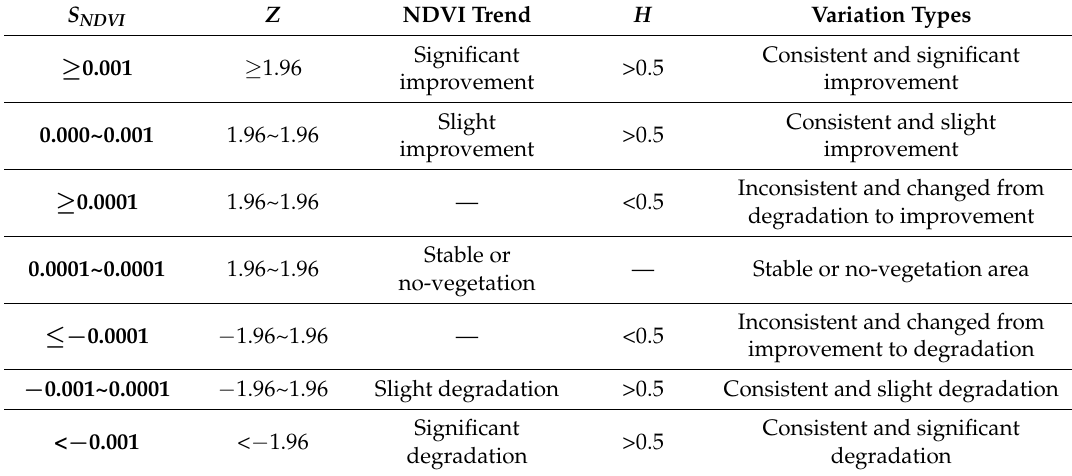
Figure 2. ( a ) Change trends of the mean NDVI in the growing season from1982 to 2015. Annual change trends in NDVI; ( b ) significant or insignificant (Z-value) and overall change trends of the mean NDVI classified into four types, namely: significant improvement, significant degradation, slight improvement, and slight degradation; ( c ) spatial distribution of the Hurst exponent; and ( d ) consistency of the mean NDVI in the growing season in Inner Mongolia from 1982 to 2015. Table 2. Vegetation change trends and division of the variation types.